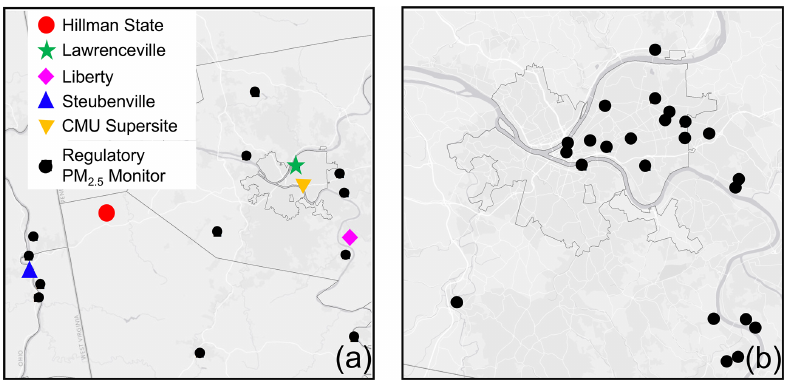
Figure 1. Monitoring sites. (a) Particulate matter speciation measurement sites from EPA-CSN and PM 2 . 5 regulatory monitors. The entire inner modeling domain is shown. (b) Low-cost sensor sites. City of Pittsburgh boundaries are shown in both panels for